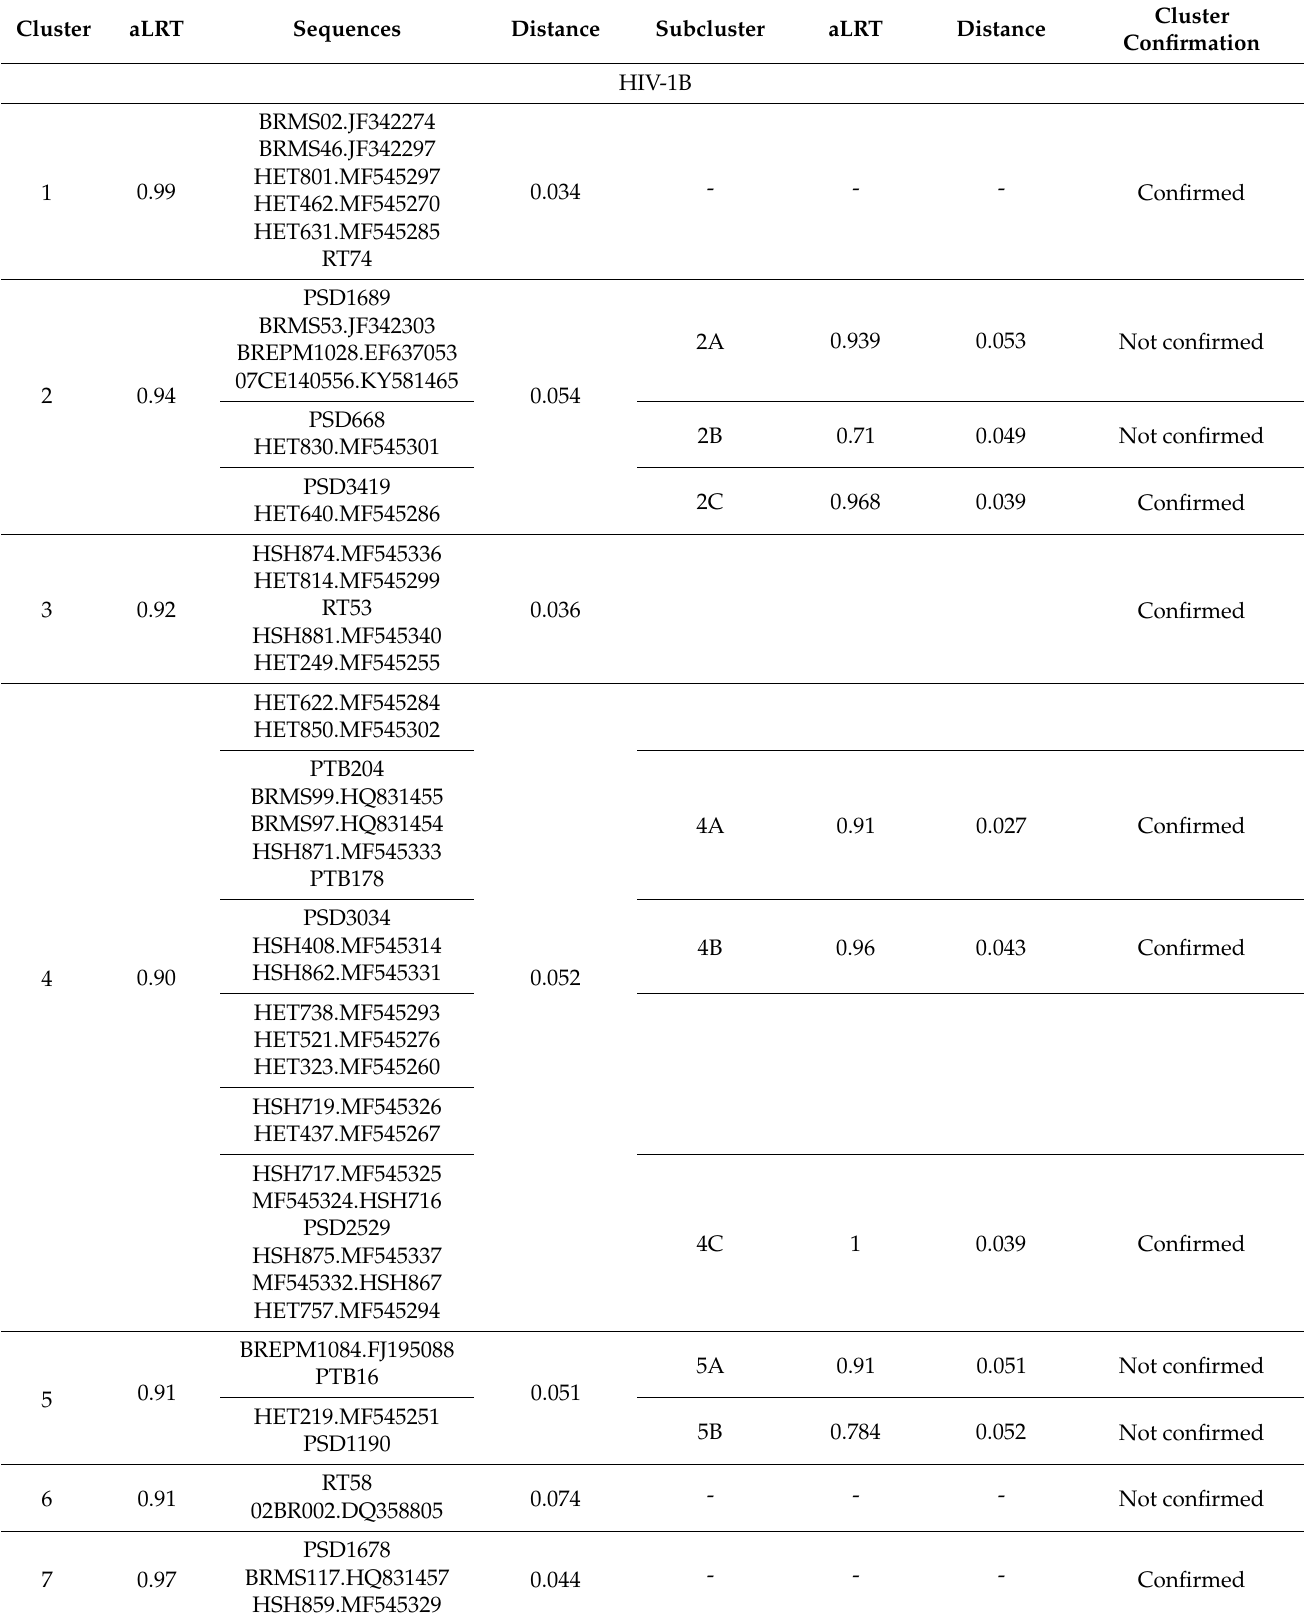
Table 1. Transmission clusters among HIV-1 prisoners’ sequences according to aLTR and genetic